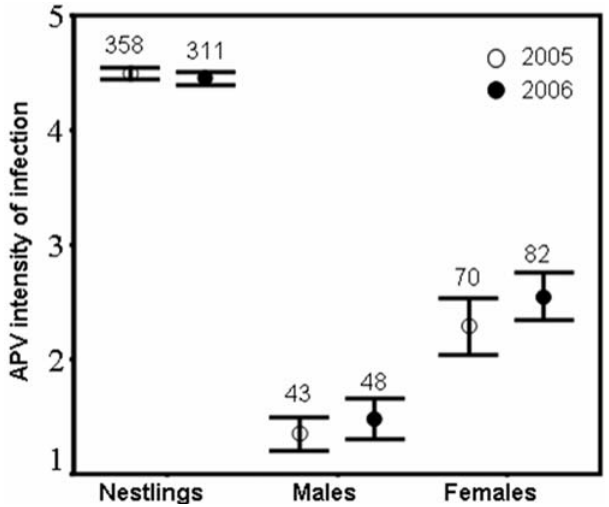
Figure 2. Relationship between the number of blowflies in the nest and the prevalence of APV in nestlings in both study years. Logistic regressions; 2005: B =1.05, Wald=118.61, P , 0.0001, n =535; 2006: B =2.55, Wald=90.22, P , 0.0001, n =625. n = 38, P = 0.31; males: x 12 = 0.88, n = 24, P = 0.88). This result indicates that APV is not passed to offspring from the mother, as occurs in mice [20], and discards the notion of strictly vertical (i.e.